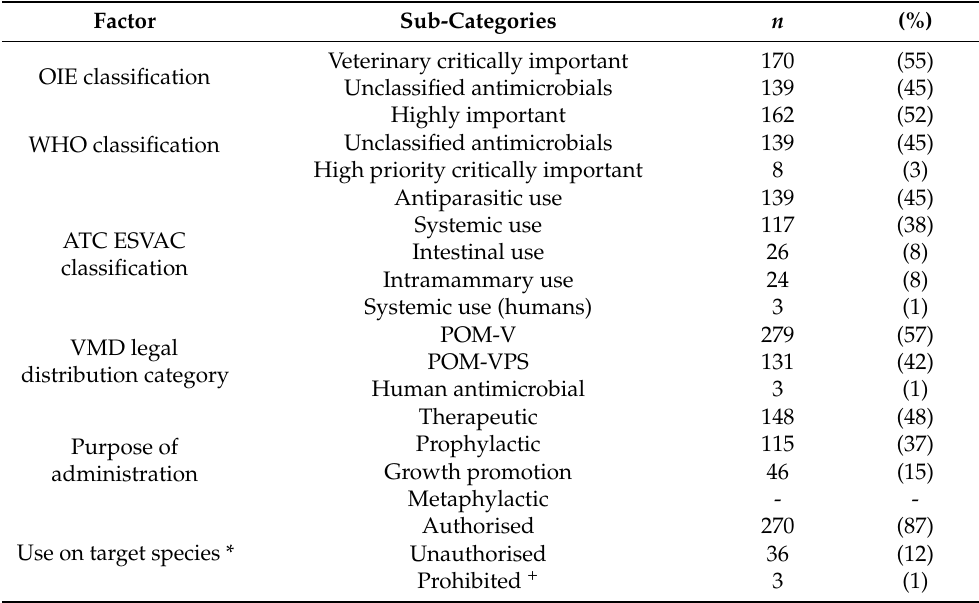
Table 3. Classification of antimicrobial formulations used in 309 incidents on 276 livestock enterprises located in Viti Levu,